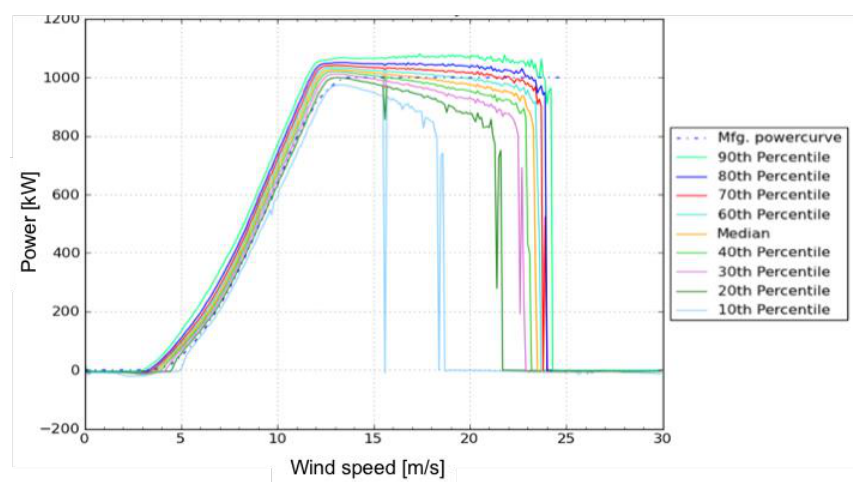
Figure 4. Power curve for a wind farm indicating percentile curves.